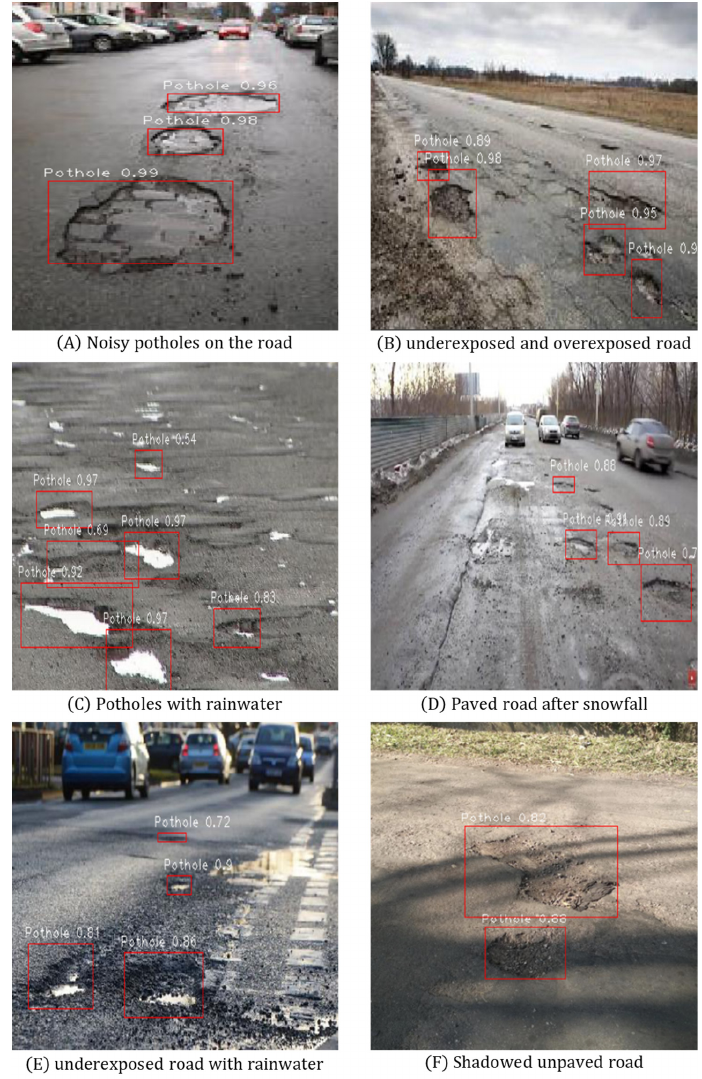
Figure 12. Detection result in the challenging condition.